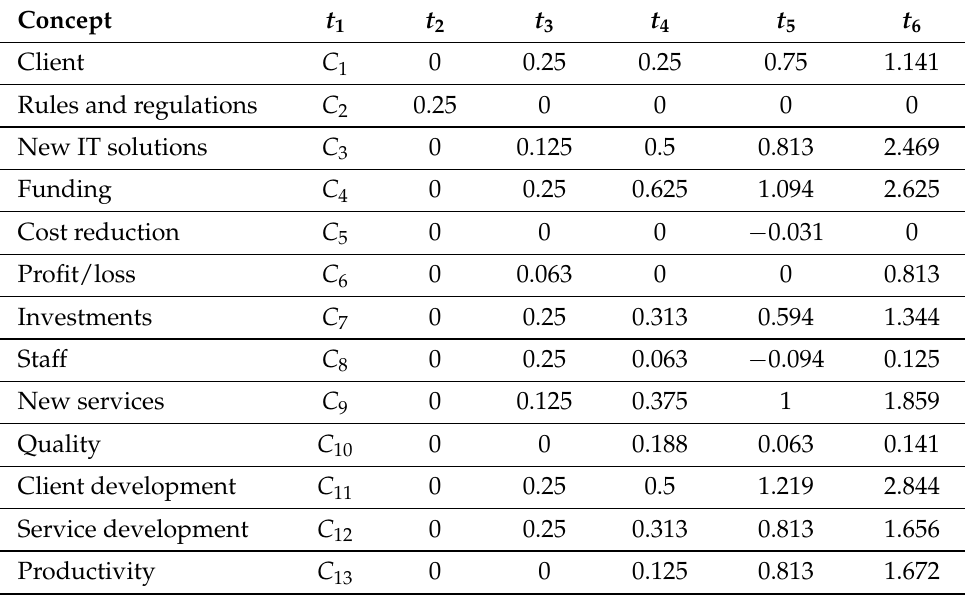
Table 14. Simulation results of the scenario of increasing the “Rules and regulations” concept in the fuzzy cognitive map determining the work of the banking